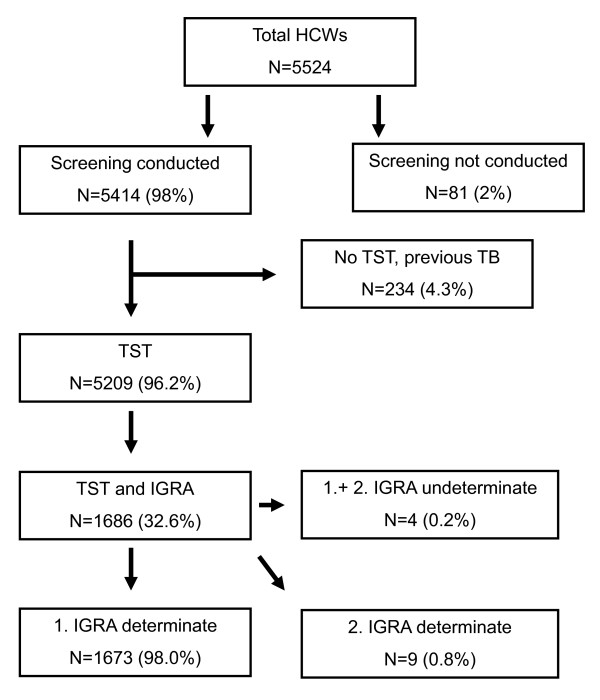
Study population.